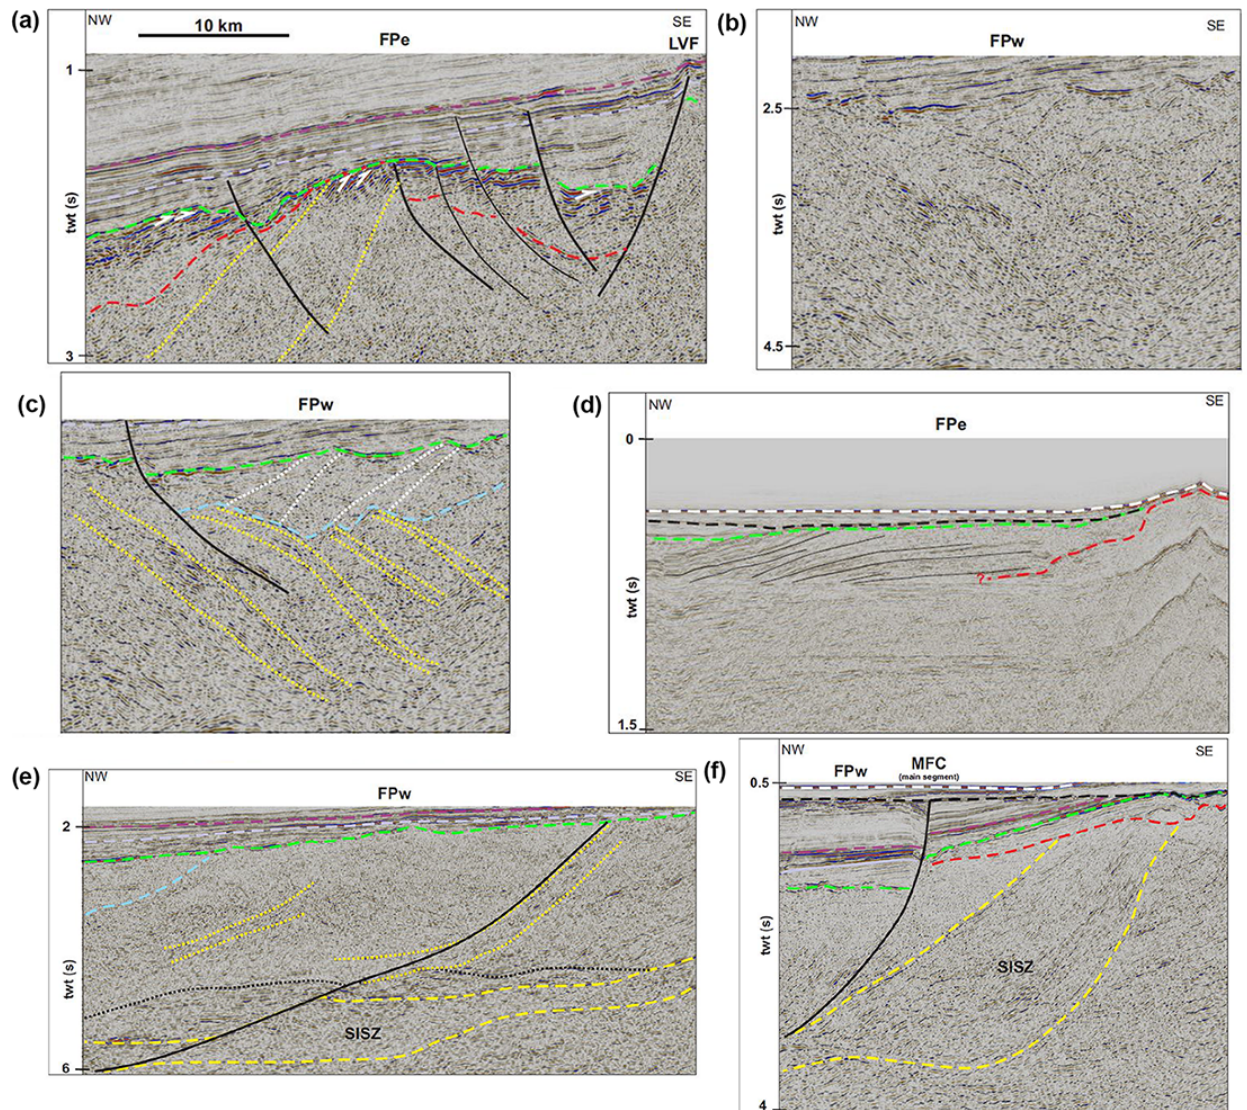
Figure 6. Enlargement of seismic sections on the eastern and western Finnmark Platform. The locations of (a) , (b) , (c) , (e) , and (f) are displayed as white frames in Fig. 5 and the location of (d) is shown as a red line in Fig. 2. See Fig. 1 for abbreviations and Fig. 5 for seismic reflection legend; (a) interpreted seismic section across the eastern Finnmark Platform. White arrows represent high-amplitude lower Carboniferous and basement seismic reflections that are truncated upwards (toplaps) by the mid-Carboniferous reflection. Note the con- trast between low-amplitude upper Carboniferous–Permian reflections; gently dipping, high-amplitude lower Carboniferous reflections; and steeply dipping, high-amplitude basement reflections that possibly belong to a basement-seated shear zone (yellow dotted lines); (b) unin- terpreted and (c) interpreted seismic zoom of a section across presumed Devonian sedimentary rocks and SE-dipping basement shear zones (yellow dotted lines) on the western Finnmark Platform; (d) interpreted seismic section from the IKU-87-BA (2-D) survey showing a thick lower Carboniferous succession made up of large clinoforms (thin black lines) on the eastern Finnmark Platform (location in Fig. 2). Note the presence of seismic artifacts in the southeast, including several multiples and NW-dipping diffraction rays; (e) interpreted seismic sec- tion across the western Finnmark Platform that displays NE-dipping basement shear zones (yellow dotted lines) including the SISZ (yellow dashed lines); (f) seismic zoom in the SISZ in the footwall of the main segment of the MFC on the western Finnmark Platform. The SISZ is composed of NW-dipping, moderate- to high-amplitude reflections that dip more gently than the MFC but that are steeper than basement reflections in the southeast. Note the significant thickness variations in the SISZ: thick in the footwall of the MFC and thin below the MFC.